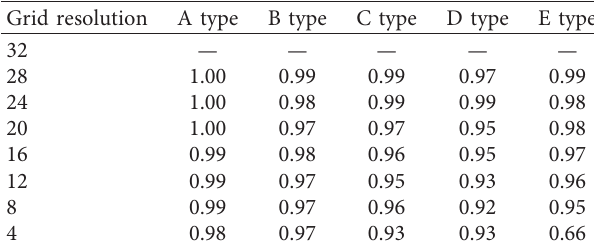
Table 4: Results of R 2 in each